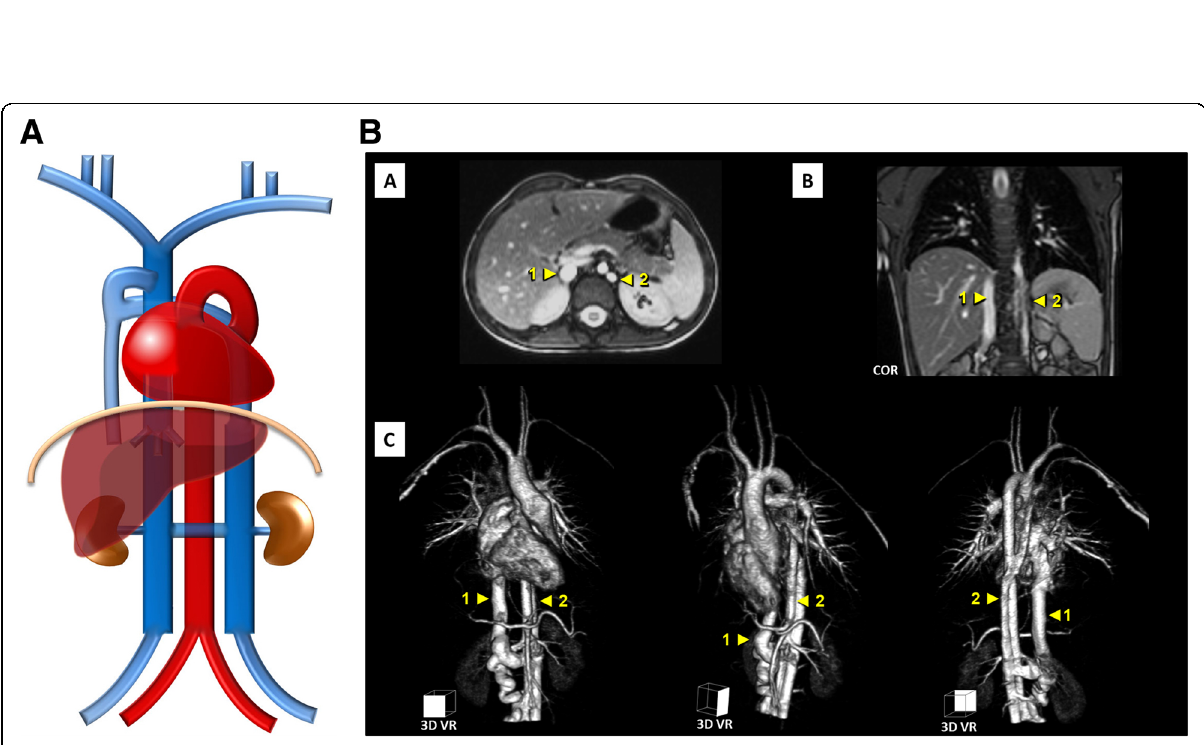
Fig. 15 a Double IVC with hemiazygos continuation of the IVC schematic. Resulting from the persistence of the in-between segment of the supracardinal vein that connects both the IVC and the azygos-hemiazygos system. b Double IVC with hemiazygos continuation of the IVC imaging. MR angiography [A — axial plane, B — coronal plane, C — volumetric 3D reconstruction] showing double IVC with hemiazygos continuation of the left-sided IVC, in which ( “ 1 ” ) — normal right-sided IVC and ( “ 2 ” ) — hemiazygos continuation of the left-sided IVC